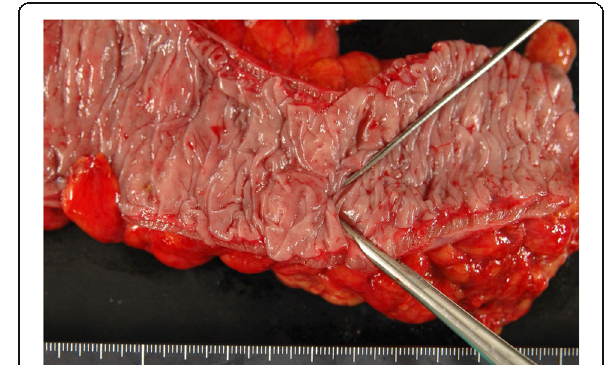
Fig. 5 Macrograph of the resected sigmoid colon showing healed diverticulitis and a large